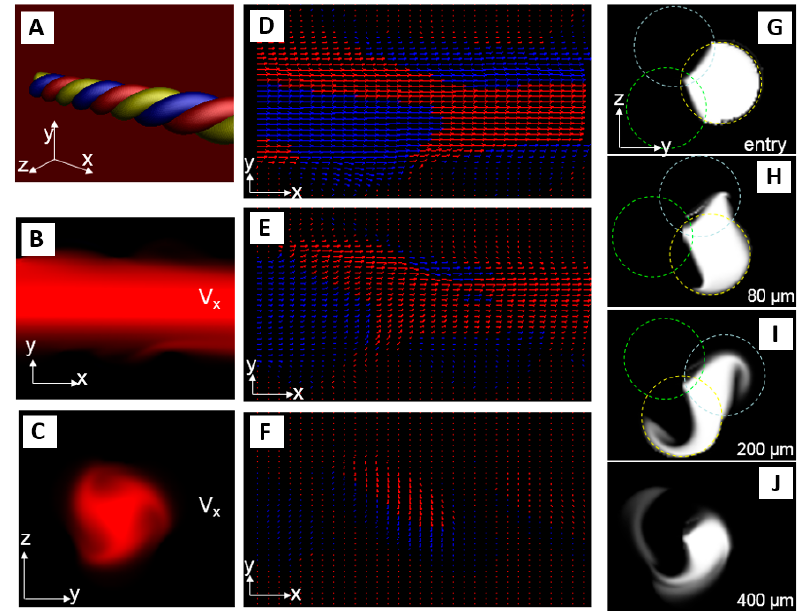
Figure 11. Solid modeling ( A ) and computational fluid dynamics ( B – J ) of triple helix channel (thread diameter = 160 μ m, driving pressure = 1.25 kPa/mm). Velocity component v x along channel axis is shown in ( B ) (longitudinal cut) and ( C ) (transverse cut). Highest velocities are found in the center, with a non-parabolic flow profile. ( D – F ) show flow vectors in longitudinal cuts at the center, partially offset from the center, and in the helix periphery, respectively (with arrows blue: z -component > 0, red: z -component < 0). Note the increasing Dean flow component (perpendicular to the channel main axis) in the periphery. A solute (diffusion coefficient 9.3 × 10 − 9 m 2 /s) is injected into one channel ( G ) and mixing observed in serial cross-sections ( H – J ): note that in addition to the diffusive component seen